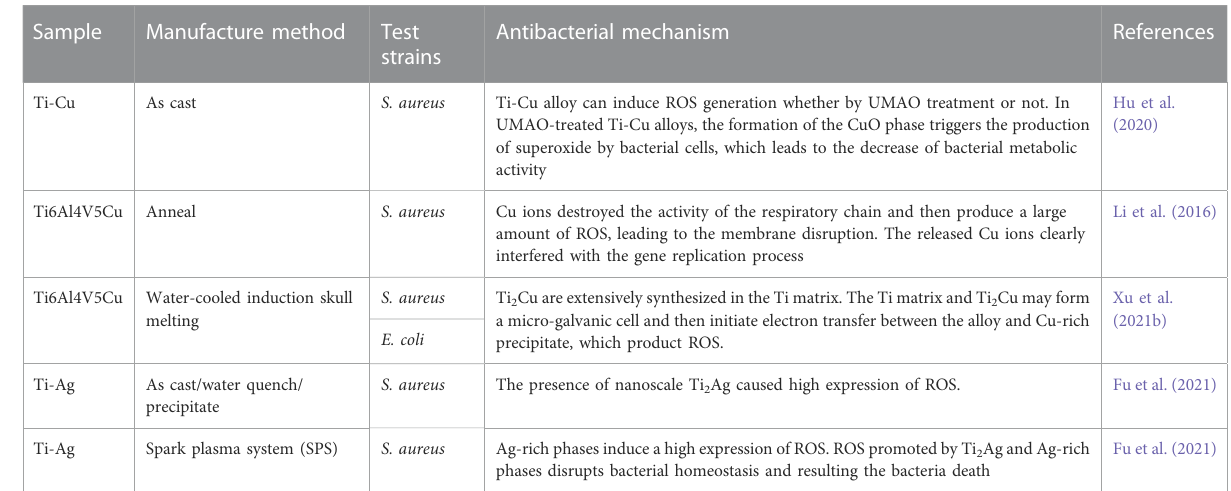
TABLE 3 Controlling oxidative stress by introducing antibacterial